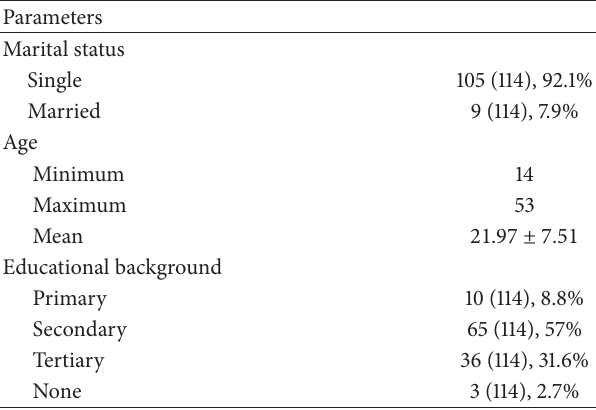
Table 1: Sociodemographic characteristics of